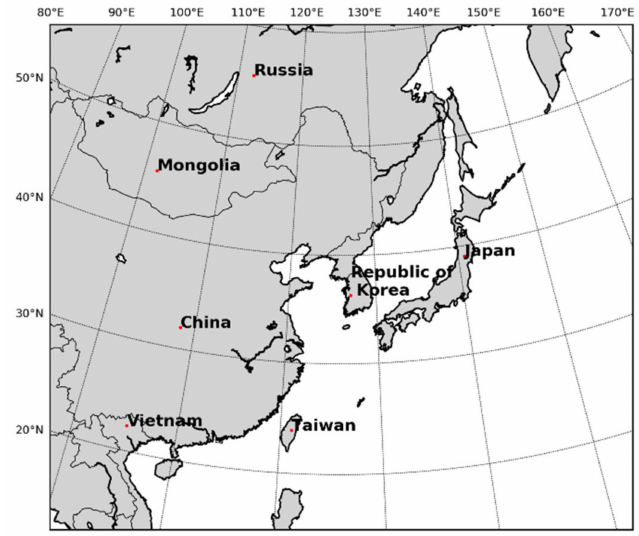
Figure 1. Study area of East